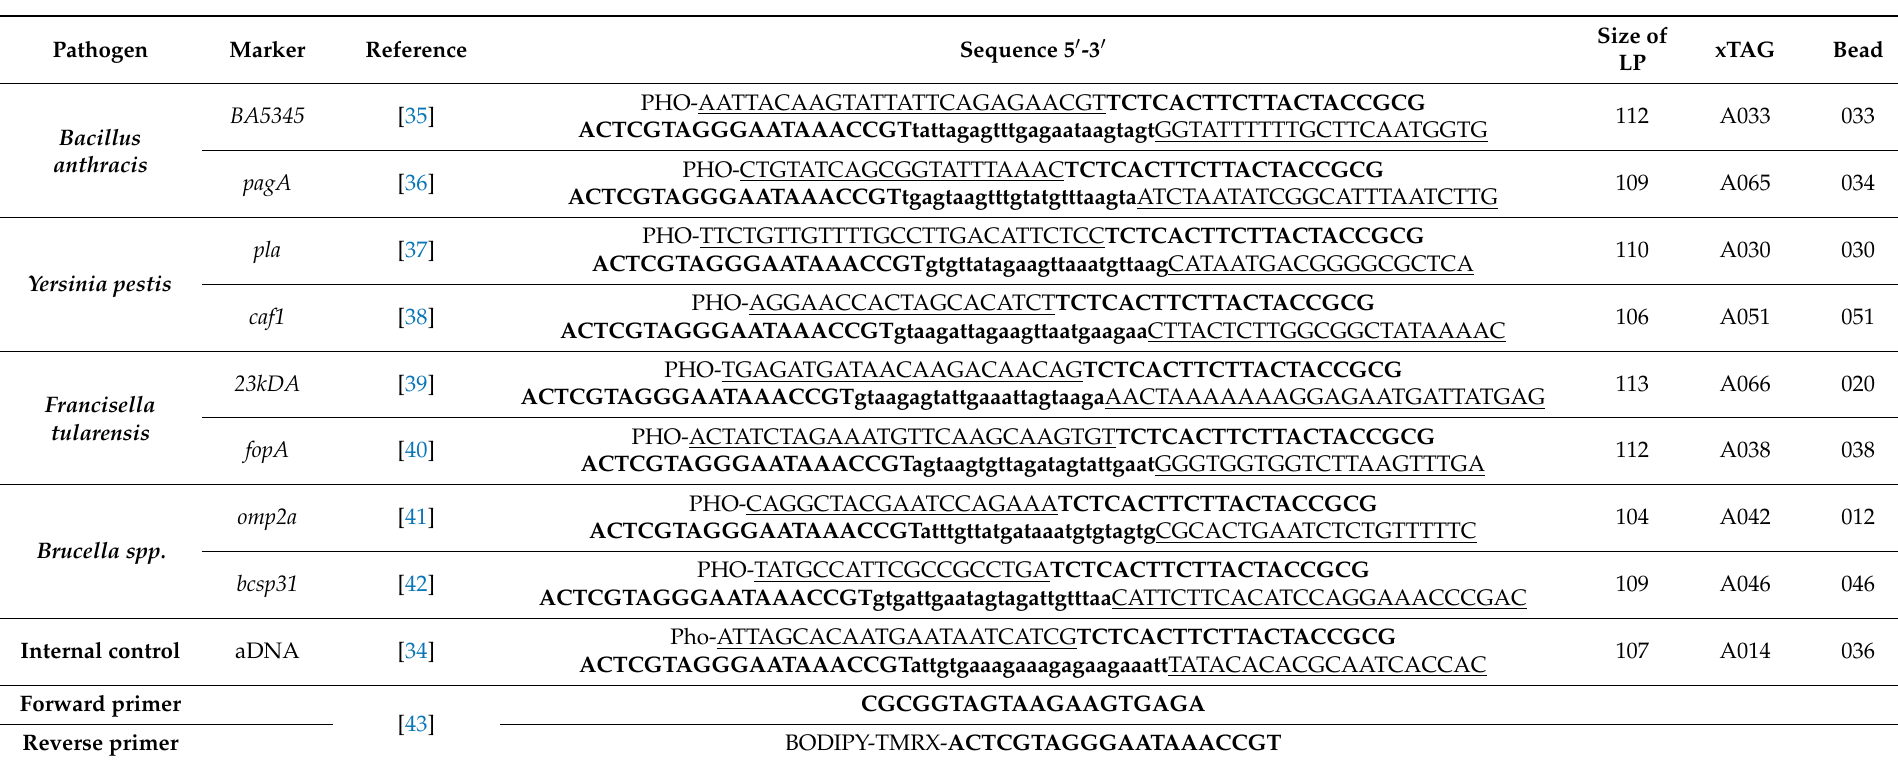
Table 2. Specific MOLigo pair sequence used for detection with microspheres code and xTAG assignation (bead and xTAG numbers of unique sequences are available in the Luminex